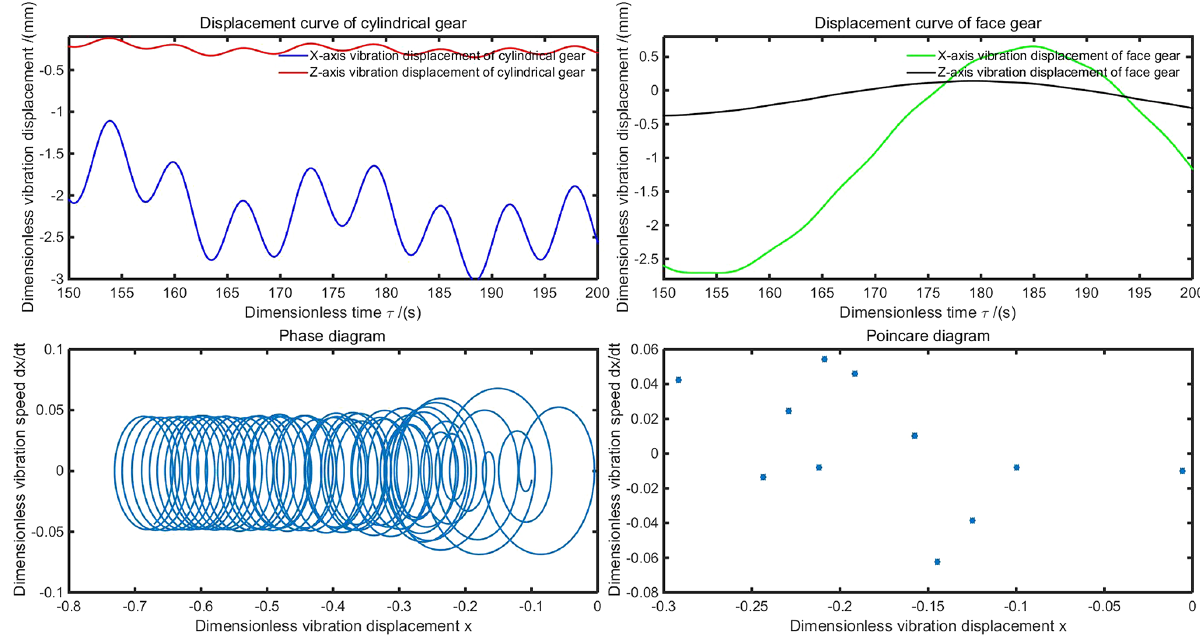
Figure 18. Displacement, phase, and Poincare diagrams of nonlinear system with friction coefficient 0.5.